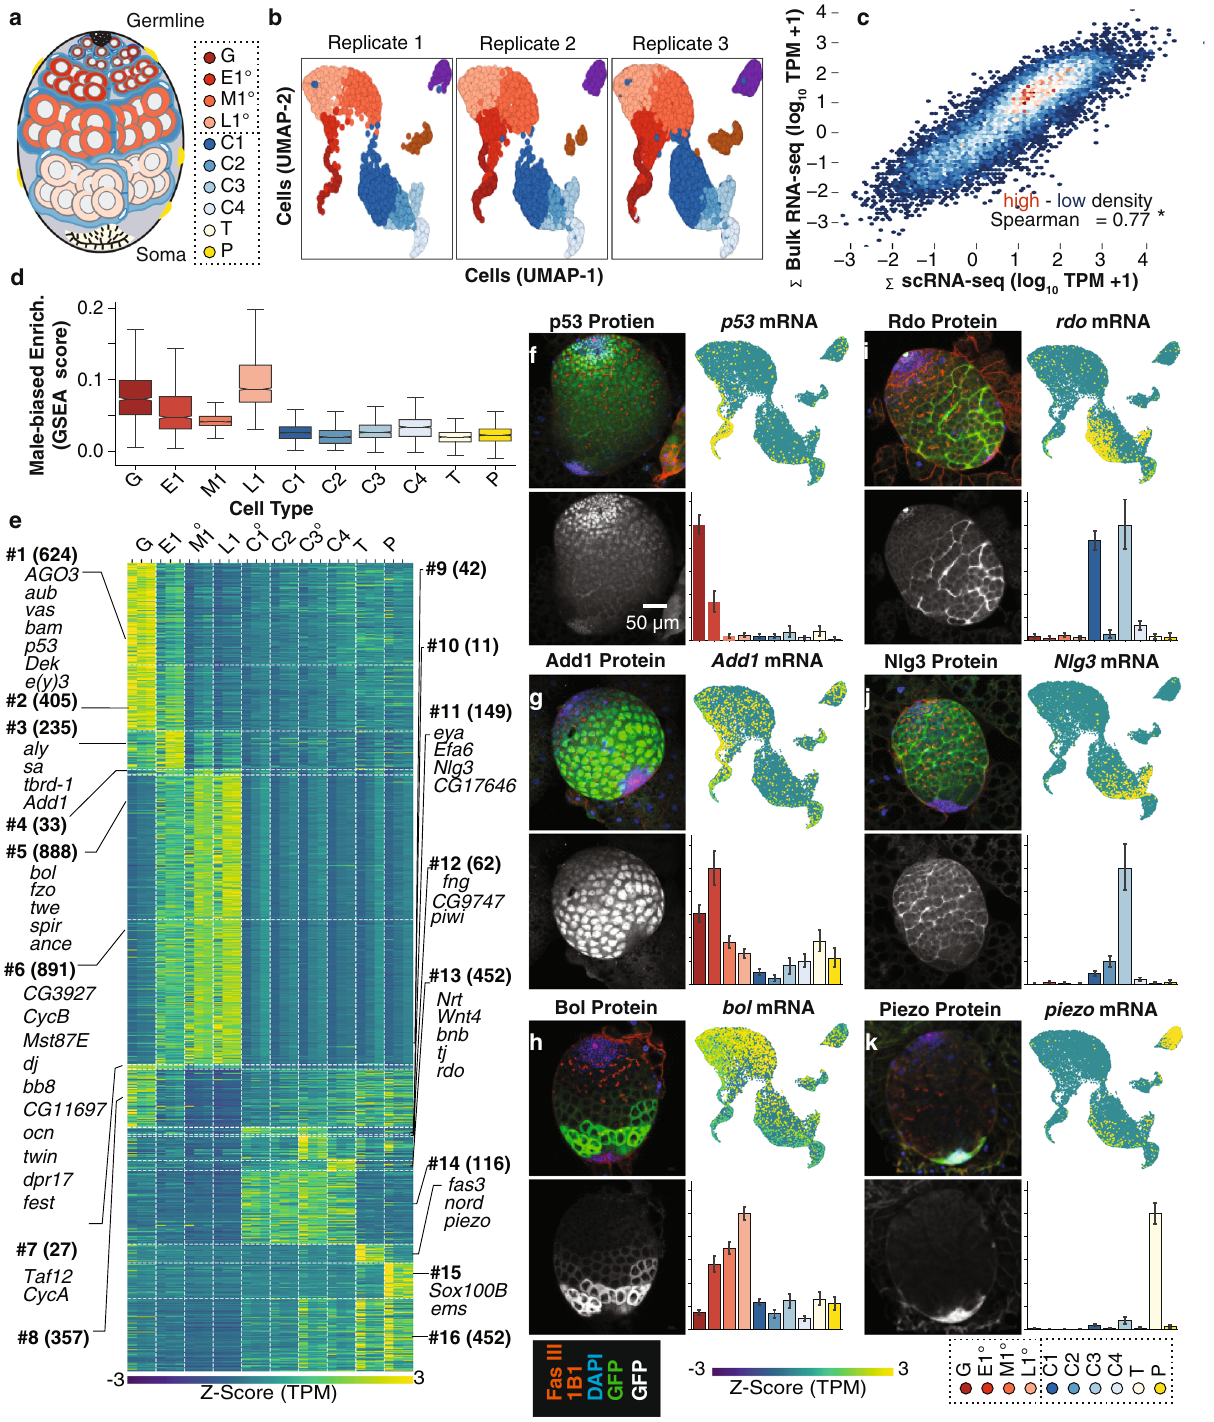
(tTAF), Aly serves as a testis-speci fi c meiotic arrest complex (tMAC) member 49 , and tbrd-1 is associated with both transcrip- tional complexes 51 . In addition, we show that ADD domain- containing protein 1 ( Add1) , which encodes a heterochromatin associated protein that interacts with Heterochromatin Protein 1 (HP1) to maintain heterochromatin 52,53 , has enriched expression in early primary spermatocytes in the scRNA-seq data. The Add1 protein accumulated throughout spermatocyte stages, consistent with translational control and/or protein stability over several days of germ cell development (Fig. 2g). The tTAFS and tMACs